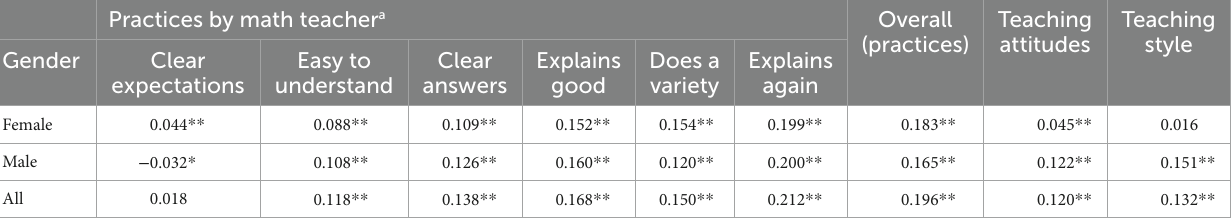
TABLE 3 Practices, style and attitudes correlations with math